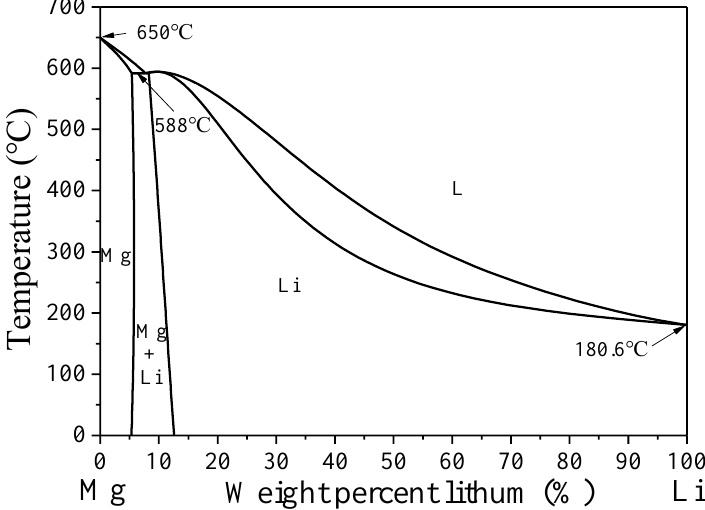
Figure 1. Binary phase diagram of Mg – Li alloys.